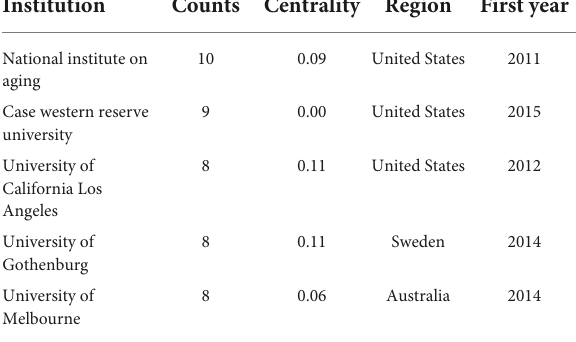
TABLE 4 Institutions’ publication number, country, and first publication